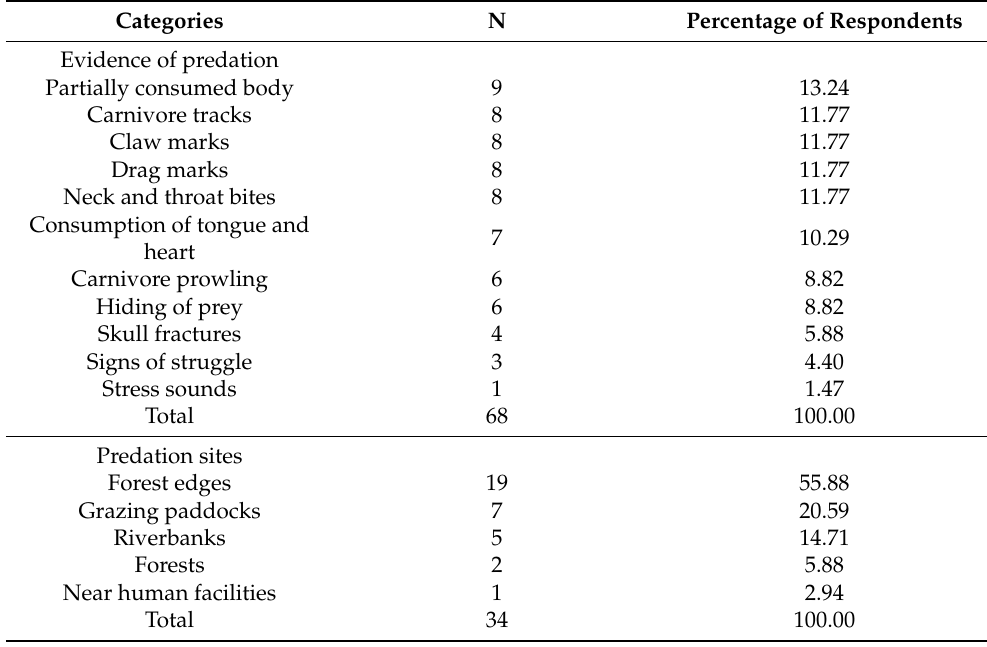
Table 2. Evidence evaluated by respondents to identify livestock predation by large carnivores and the sites where predation frequently occurred. Some respondents mentioned more than one